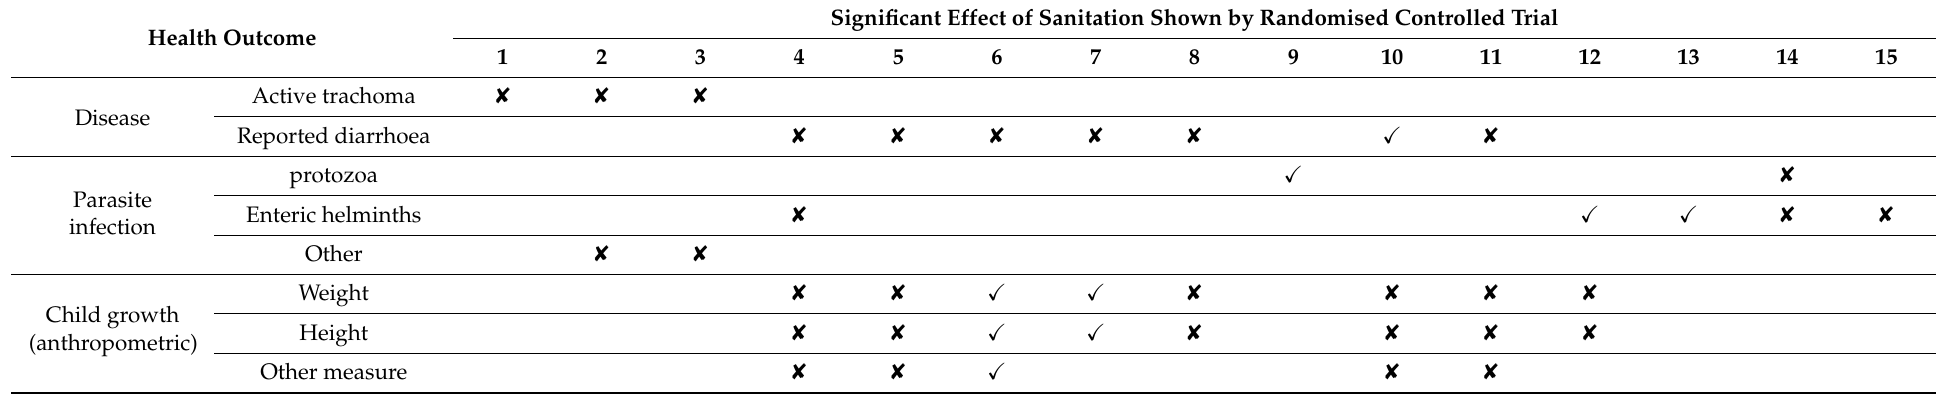
Table 4. Summary of results showing the effect of sanitation interventions on disease, parasite infestation and child growth. Significant Effect of Sanitation Shown by Randomised Controlled Health Outcome